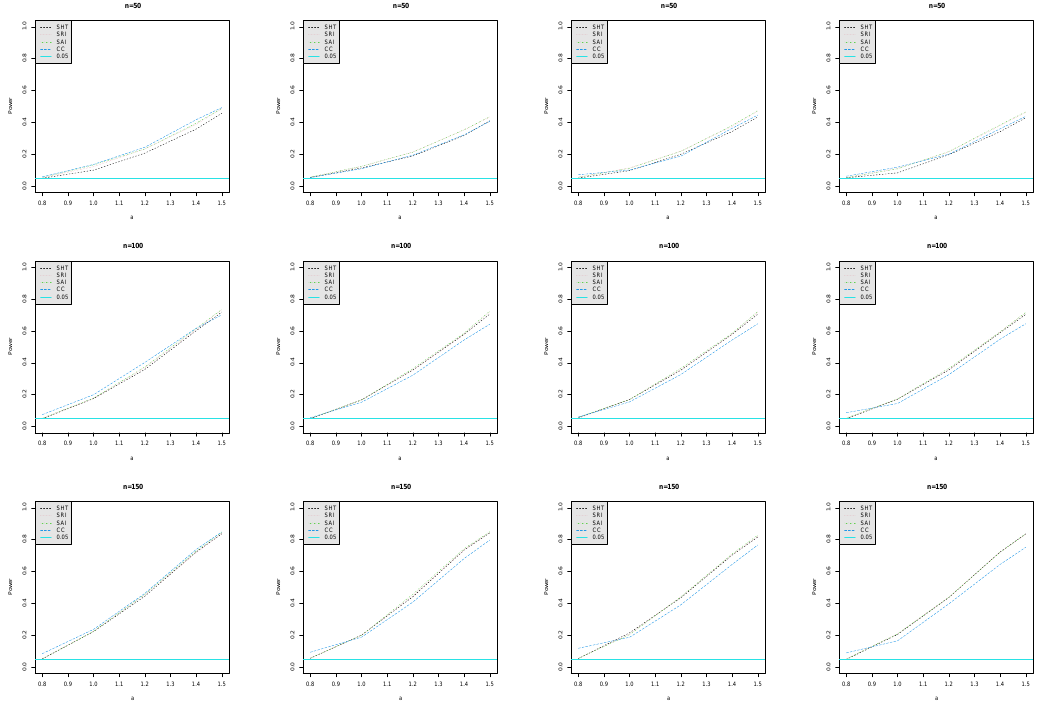
Figure A1. SHT, SRI, SAI and CC represent empirical powers evaluated from IPW, regression imputation, AIPW and CC methods against a for missingness data mechanism model E1 (left panel), E2 (left second panel), E3 (right second panel) and E4 (right panel) for n = 50 (the first row), 100 (middle row) and 150 (the last row) under the balanced